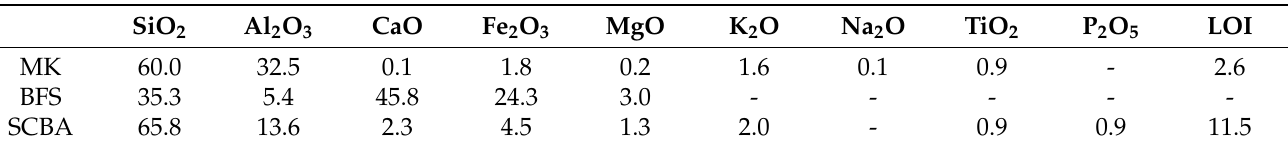
Table 2. Chemical composition of precursors metakaolin (MK), slag (BFS) and sugarcane bagasse ash (SCBA) (mass%).